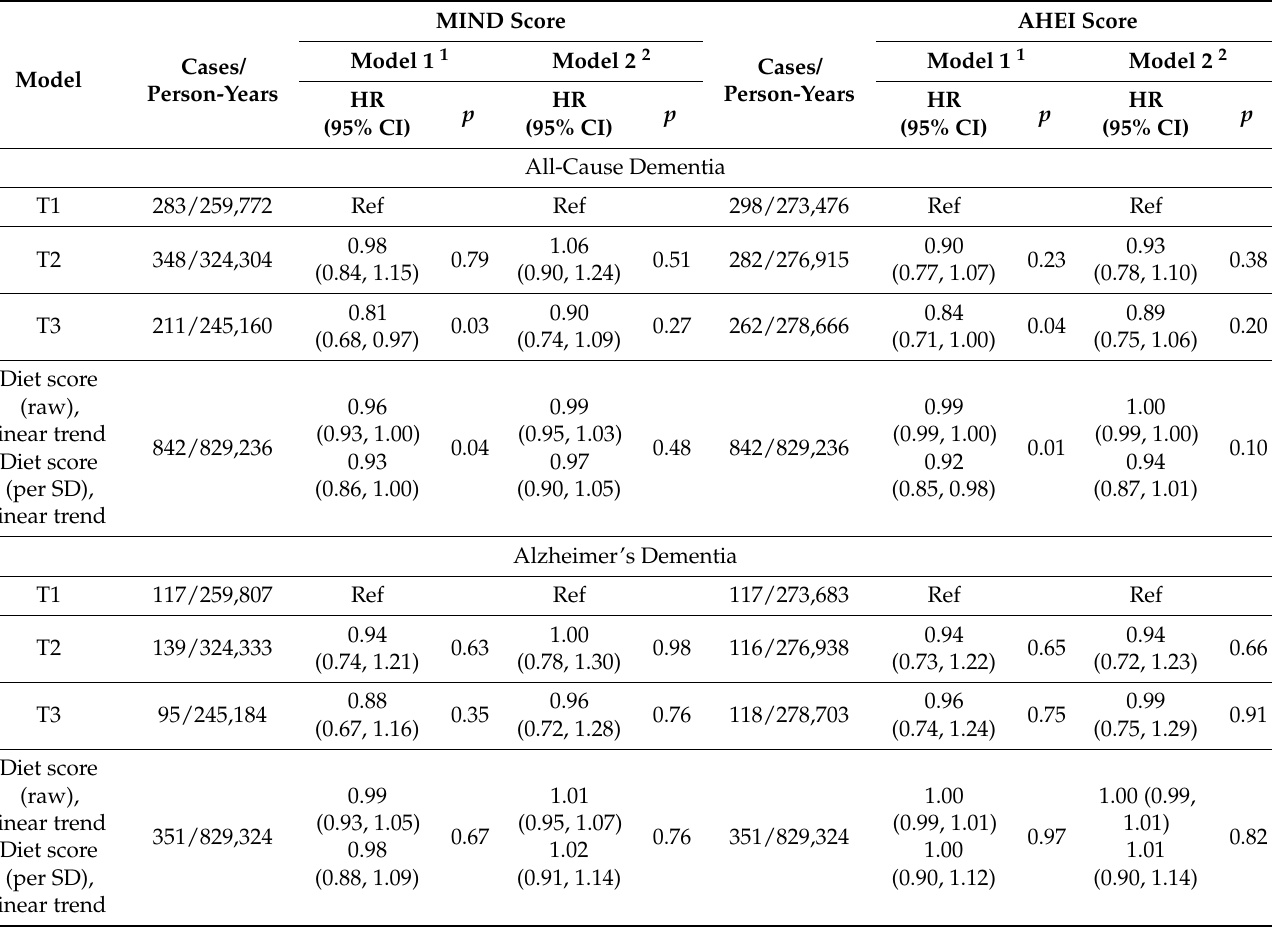
Table 5. MIND/AHEI-2010 adherence and incident dementia (age 55+ years at